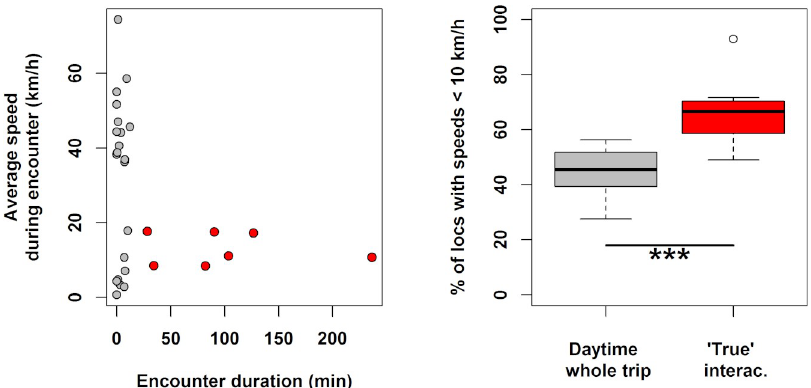
Fig 4. Vessel encounter characteristics. (Left): Average Cape gannet traveling speed and contact duration of 28 radar “encounters” by gannets (from 13 individuals), used for visual categorization; the seven encounters identified as true attendance (from 5 individuals) are highlighted in red. (Right): Proportions of speeds < 10km.h -1 during trips as a whole (during day time hours: left) or during the seven “true” attendance (right, red, ��� : Wilcoxon test, p <